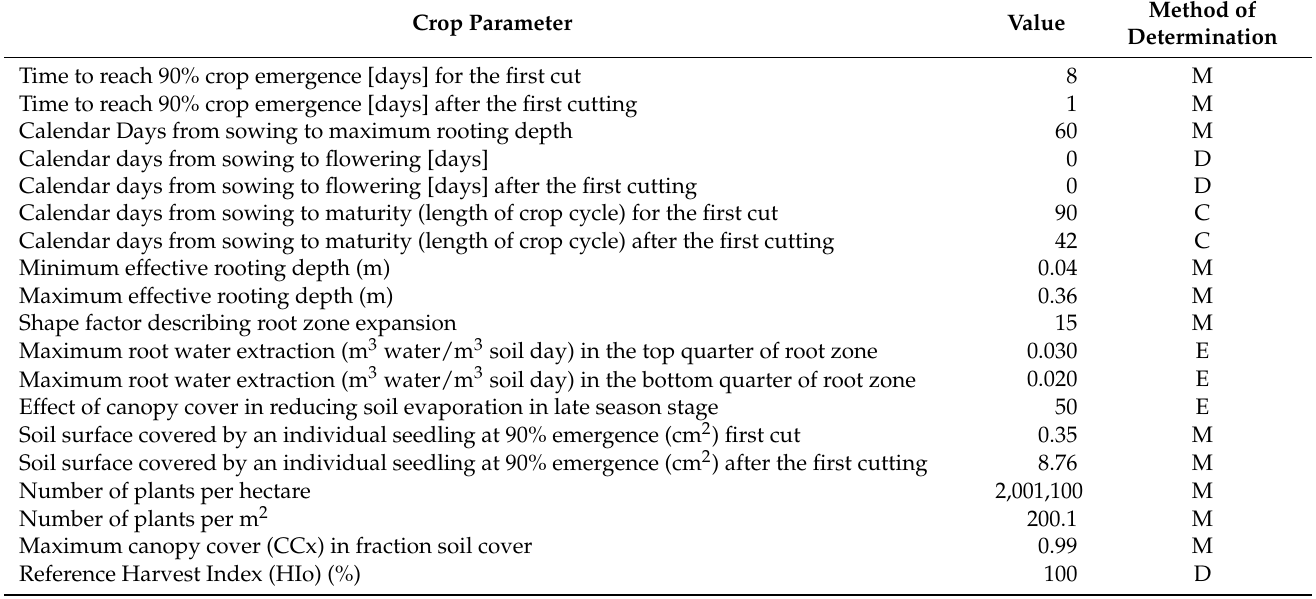
Table 5. Non-conservative parameters used in calibrating and validating the model for simulating